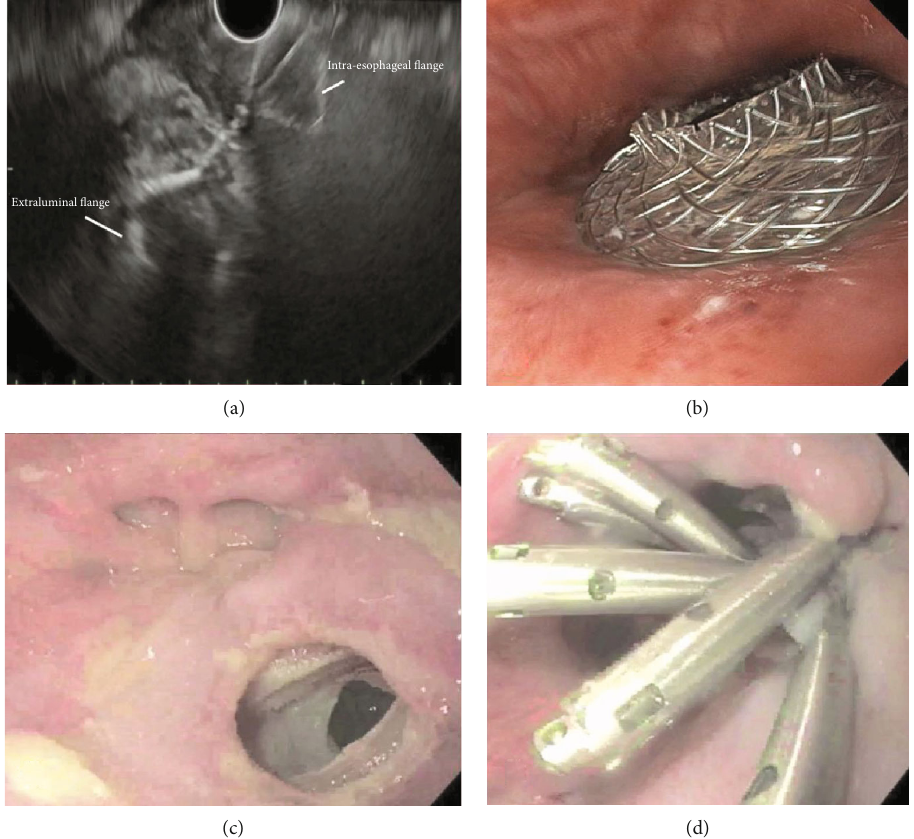
Figure 2: Patient with a mediastinal collection adjacent to the esophagus. (a) Endosonographic image showing deployment of a 10 mm diameter lumen apposing metal stent (LAMS). (b) Endoscopic image of the proximal fl ange placed in the esophagus. (c) Endoscopic image of the esophageal defect after LAMS removal. (d) Endoscopic image of the esophageal defect closed with